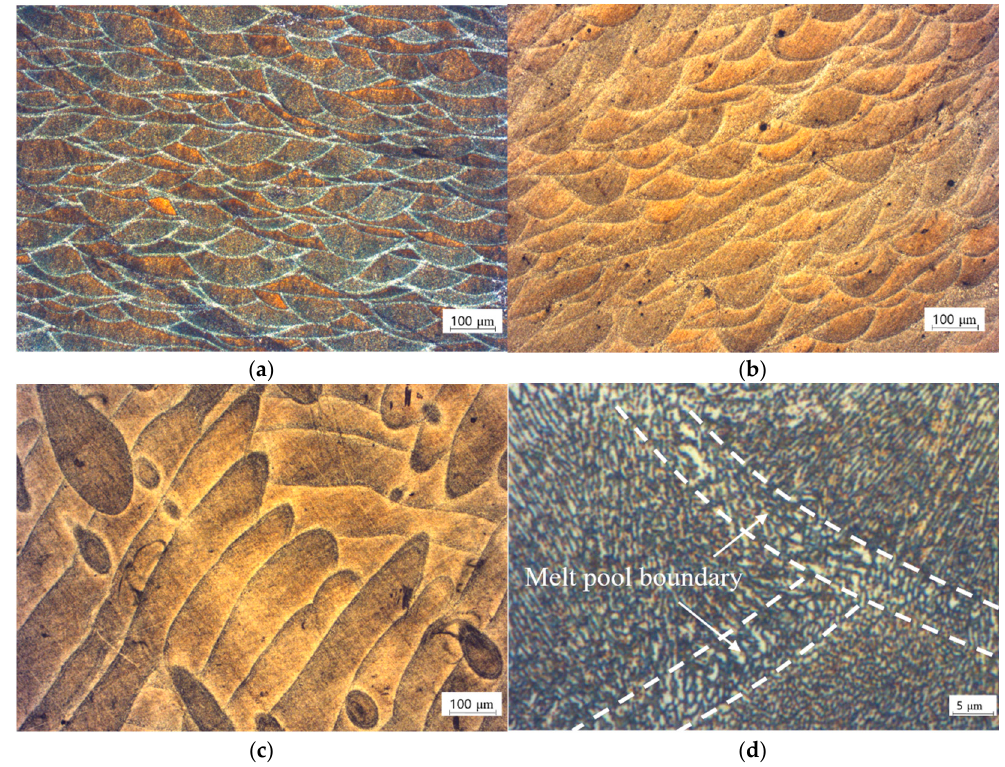
Figure 9. Optical microscope image of melt pool on the wide surface of a specimen from case 2 with polar angles of ( a ) 0°, ( b ) 45°, and ( c ) 90°; and, ( d ) microstructure inside melt pool.